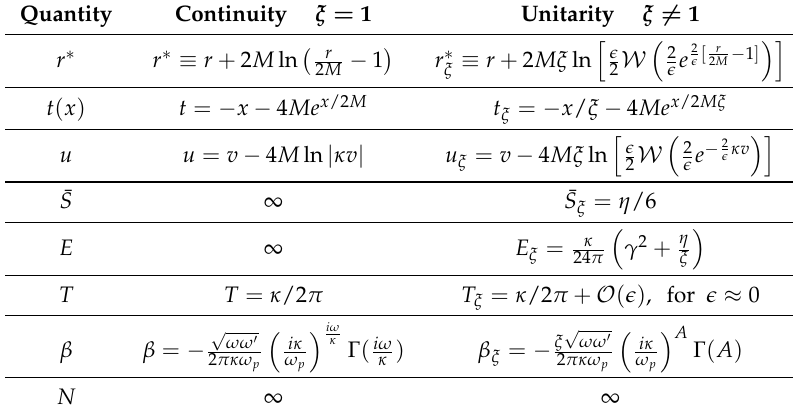
Table 1. Summary of